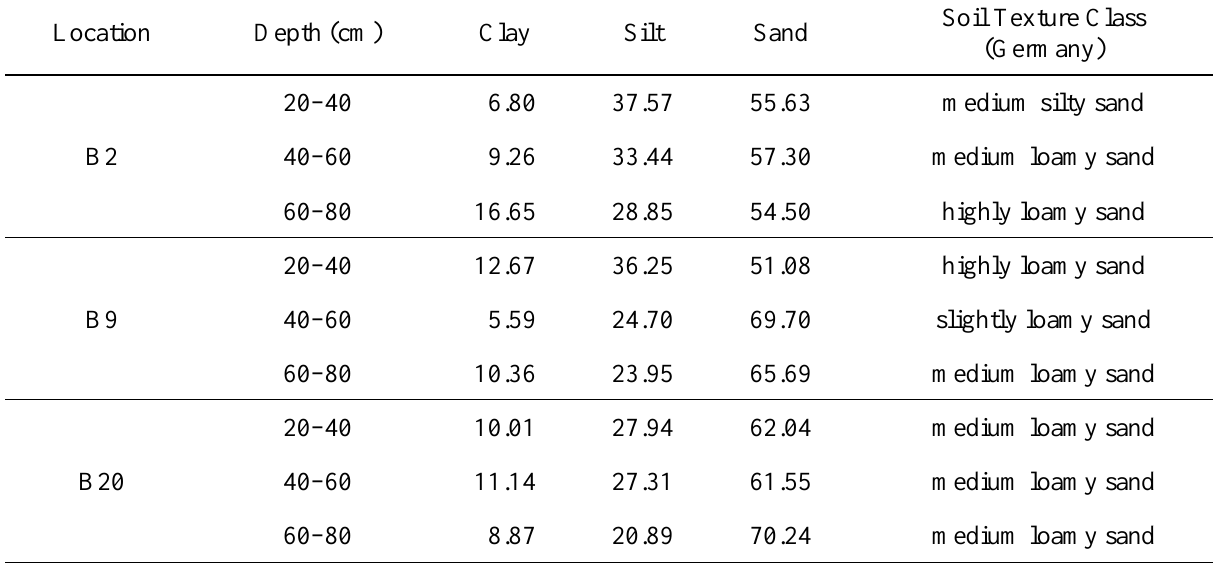
Table 2. Soil texture classes according to German classification (Eckelmann et al. 2006). The English terms for the German soil classes were used after Bormann